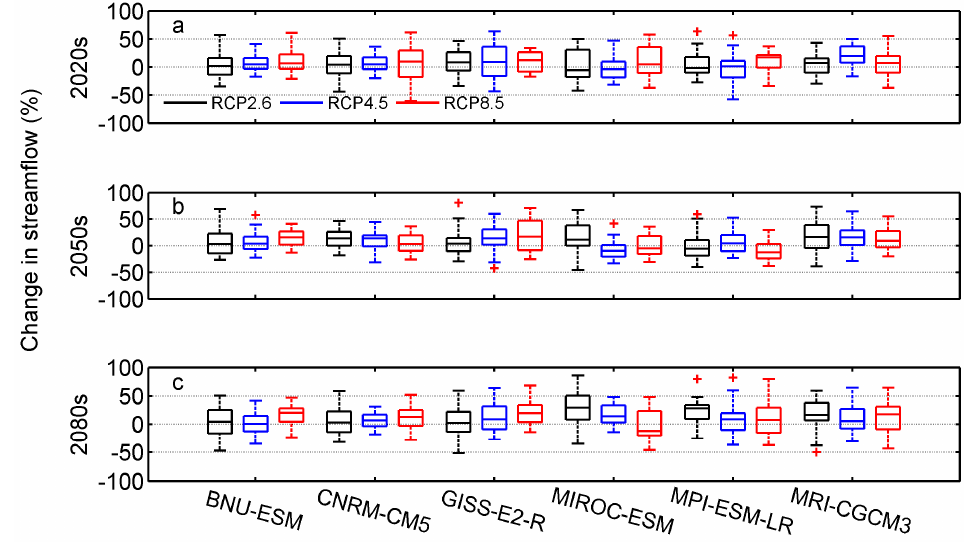
Figure 9. Box plots of change ratios in seasonal streamflow (%) in the future periods (( a ) 2020s, ( b ) 2050s and ( c ) 2080s) under RCPs (RCP2.6, RCP4.5 and RCP8.5).